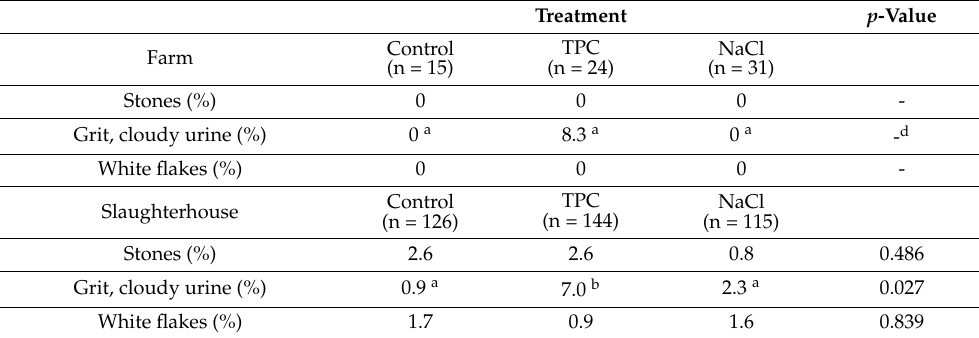
Table 5. Macroscopic findings (stones/grit/white flakes) of the urine samples taken at the farm and in the slaughterhouse from fattening pigs given three dietary treatments: the control group (control) received the normal feed used on the farm, the tripotassium citrate (TPC) and the sodium chloride (NaCl) groups received the normal feed supplemented with 0.25% TPC and 0.20% NaCl, respectively.